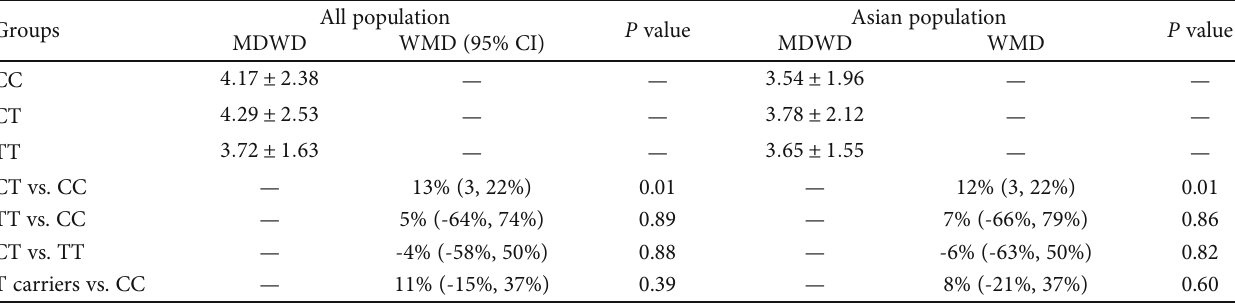
Table 2: The mean values of warfarin dose for each genotype and comparison of the e ff ect of variant NQO1 rs1800566 genotypes on warfarin dosage requirement in Asian and all populations.